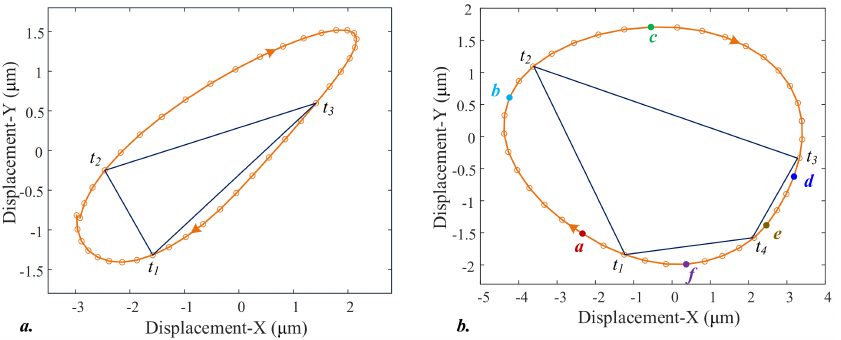
Figure 16. The elliptical motion trajectory: ( a ) period A in the transient state; ( b ) period B in the steady state.